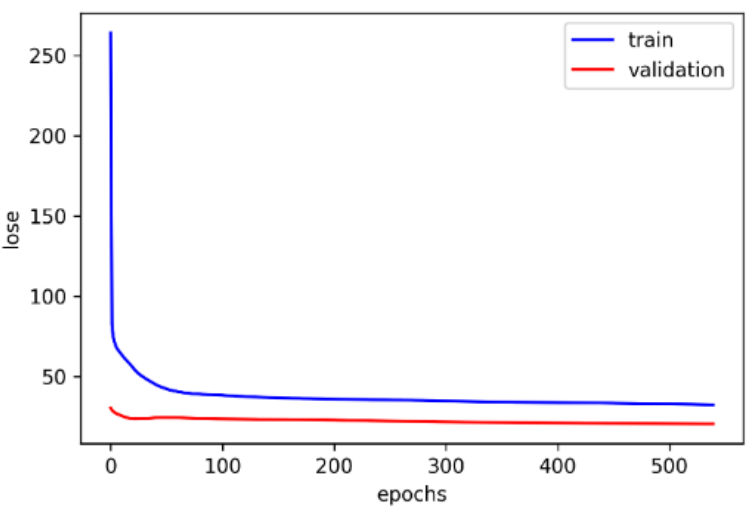
Figure 6. Training convergence curve.